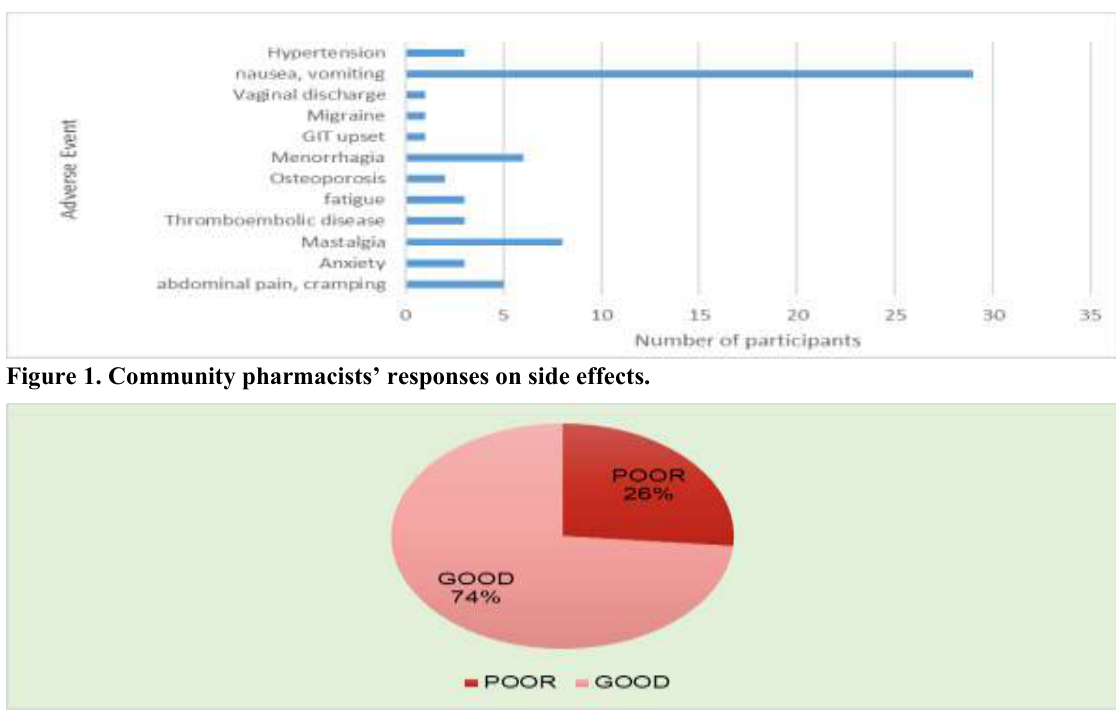
Figure 2. The knowledge level of the study participants. Relationship between sociodemographic characteristics and the knowledge level of the community Pharmacists